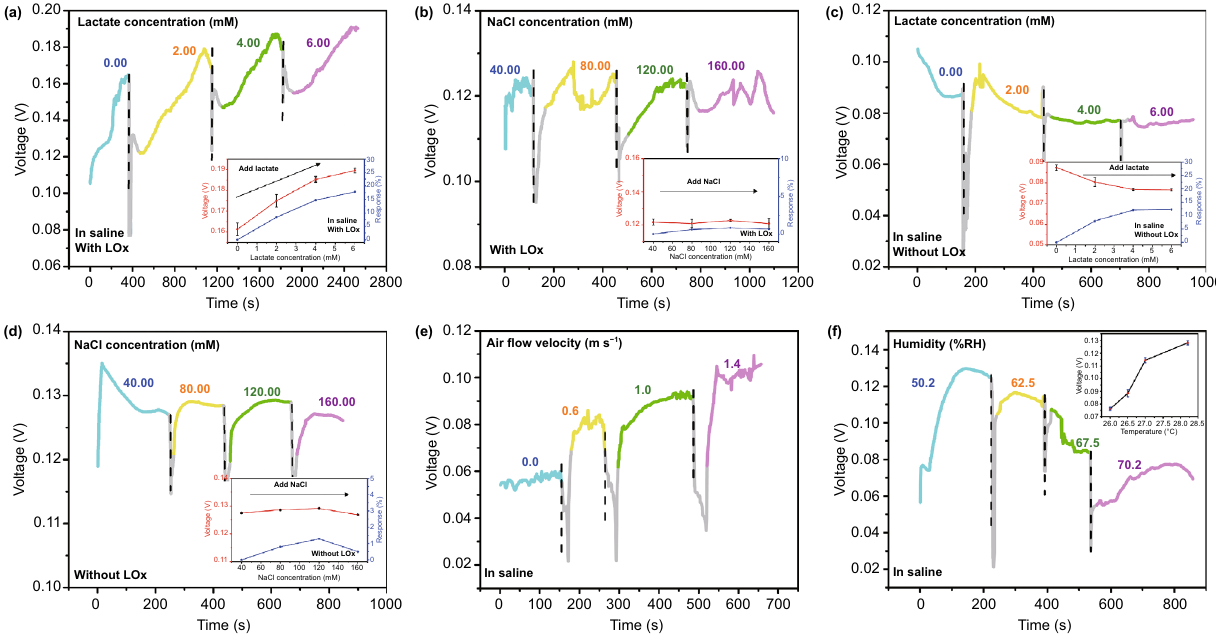
Fig. 3 a Biosensing behavior of the perspiration analyzing sites against small lactate concentration. b Effect of small gradient NaCl Concentra- tion on device outputting voltage. c Outputting voltage of the device without LOx modification against different lactate concentration. d Output- ting voltage of the device without LOx modification against different NaCl concentrations. e Outputting voltage of the device with LOx modifi- cation against different air flow velocity. f Outputting voltage of the device with LOx modification against different humidities and